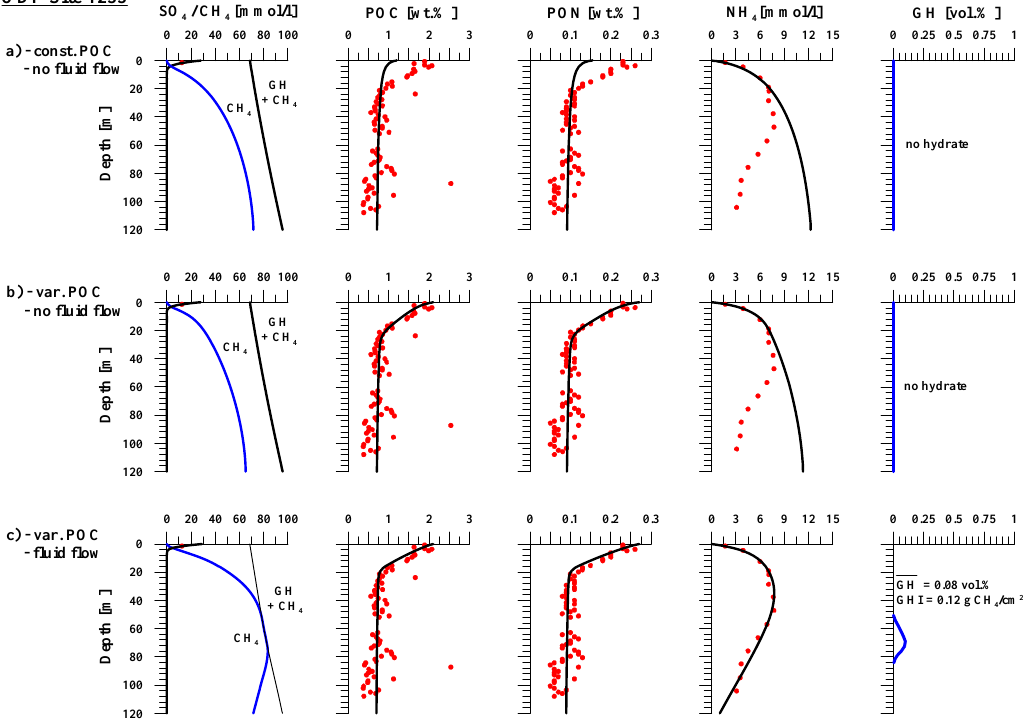
Fig. 4. Model results for ODP Sites 1233 off Chile for three different model runs: (a) constant POC input, (b) varying POC input, and (c) varying POC input combined with advective fluid Figure 4. Model results for ODP Sites 1233 off Chile for three different model runs: a) constant POC input, b) varying POC input, and c) varying POC input combined with advective fluid flow.